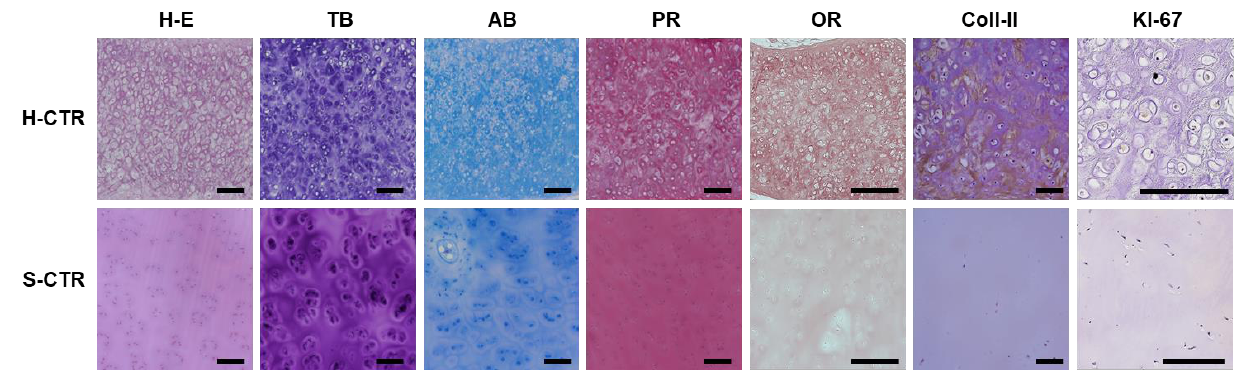
Figure 2. Histological analysis of control H-CTR and S-CTR with hematoxylin-eosin staining (H-E), toluidine blue (TB), alcian blue (AB), picrosirius red (PR) and orcein (OR) histochemistry, and immunohistochemistry for type II collagen (Coll-II) and KI-67 proteins. Scale bars: 200 µm.